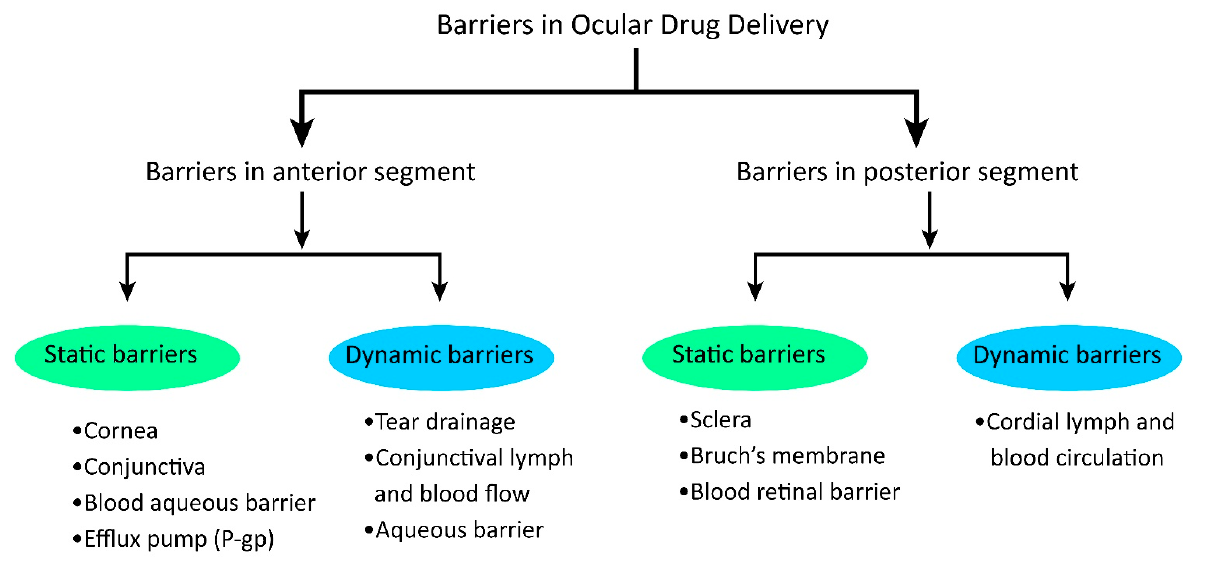
Figure 3. The characteristics that make chitosan a nanomaterial and a promising candidate for nanotechnology-mediated ocular drug delivery in glaucoma.